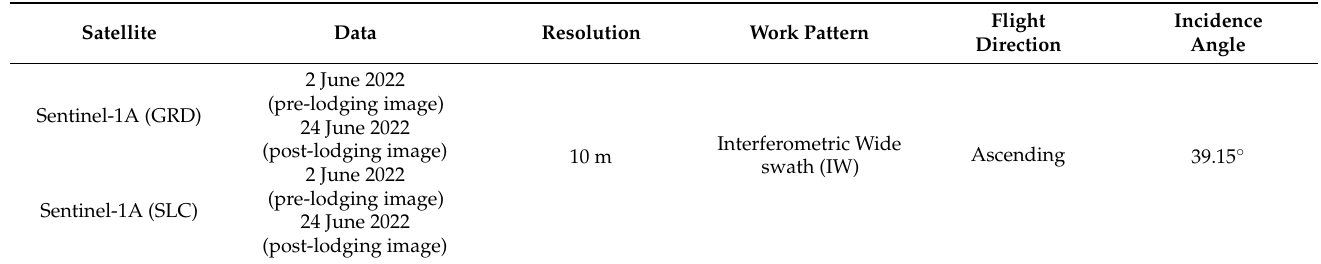
Table 1. Sentinel-1 data used in this study.